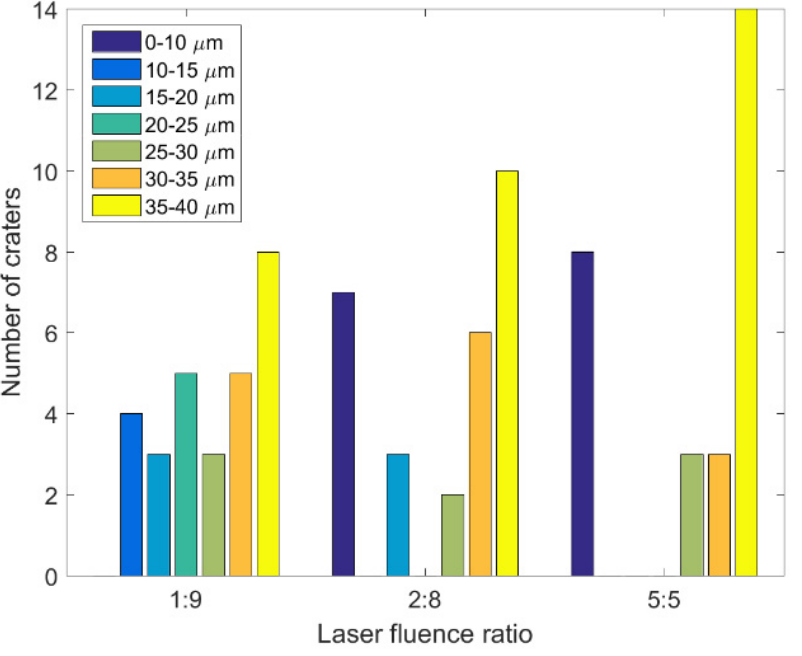
Figure 6. Diameter range histograms of the craters ablated by double pulses with three laser fluence ratios when the delay time was 0 ps. Table 1. The distribution of the ablation craters’ diameters under a double-pulse delay time of 0 ps.